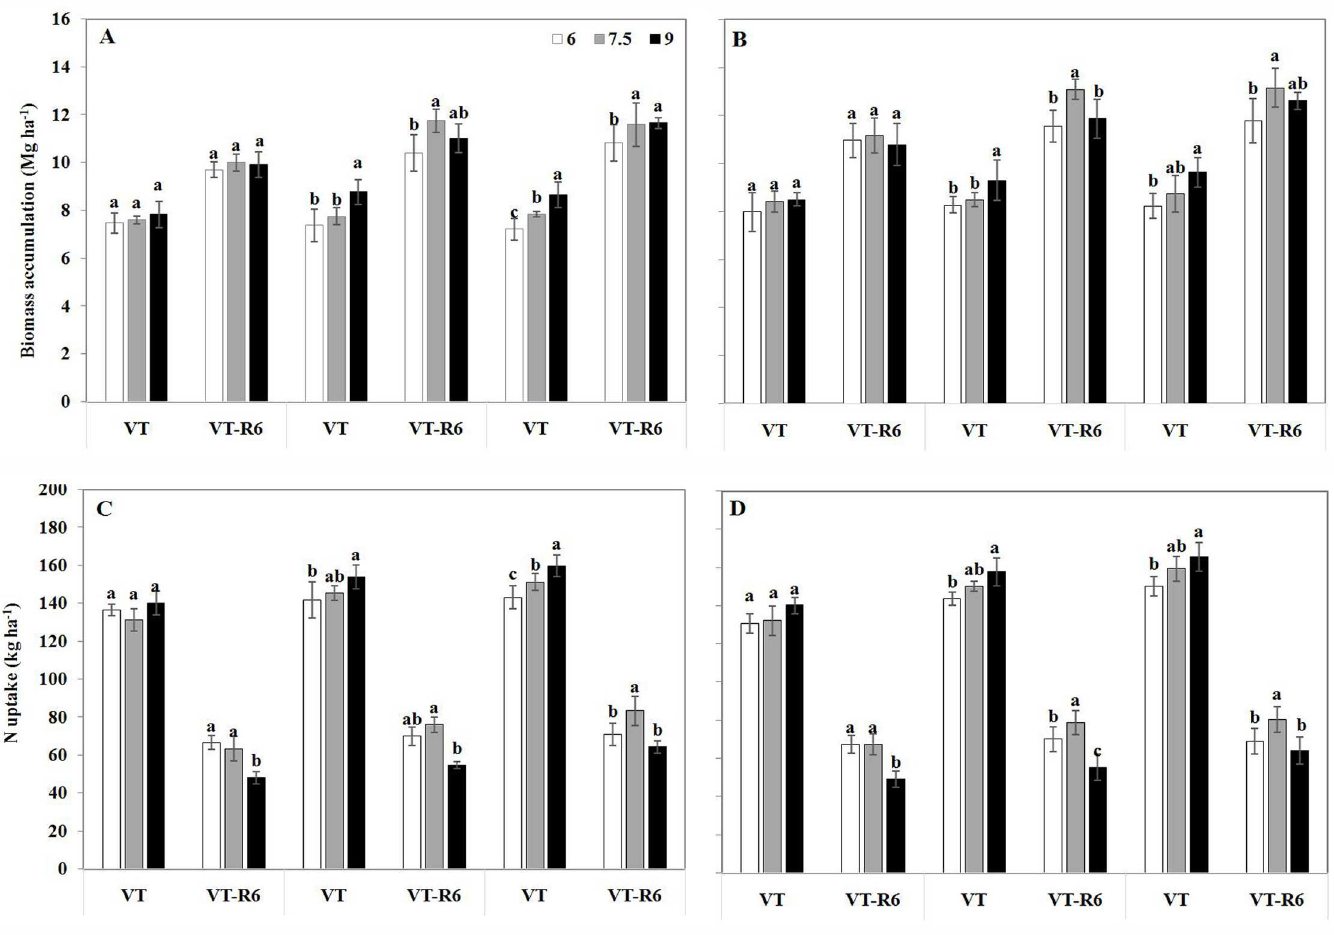
Fig 2. Pre-and post-silking maize biomass accumulation and N uptake ( ± S.E.) as affected by plant densities for various N-management schemes during the two-year study. Pre-andpost-silkingmaize biomass accumulationin 2013 and 2014 in panels A–B, respectively, and pre-andpost-silkingmaize N uptake in 2013 and 2014 in panelsC–D, respectively.VT, silking stage; R6, harvest (maturity) stage, VT-R6 means the biomass accumulationand N uptake duringthe post-silkingperiod. Lower case letters indicatesignificantdifferencesbetweentreatments at the P < 0.05 level.